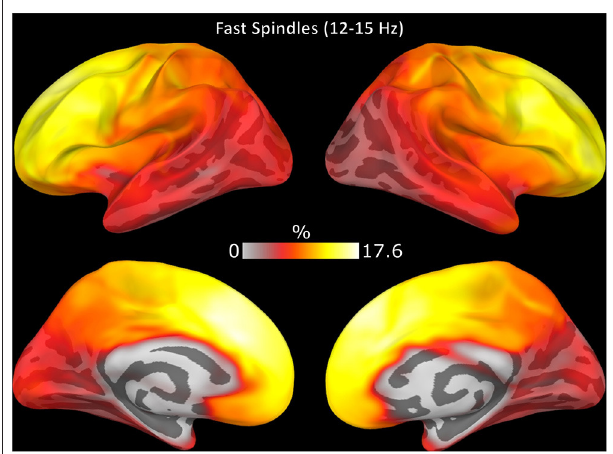
FIGURE 4 | Topography of spindle events detected only in source space EEG (FPs). The color of each region represents the number of FPs expressed in this region over the total number of FPs as a percentage.